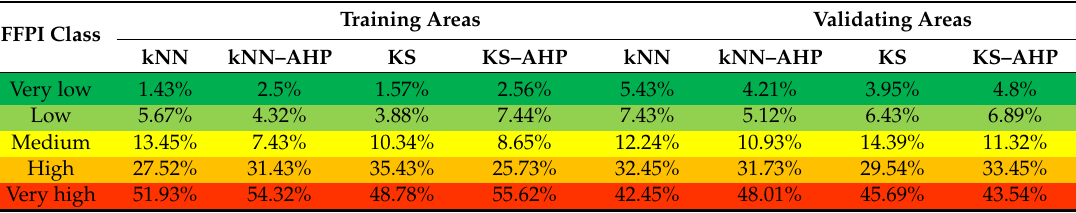
Table 3. Share of torrential pixels in Flash-Flood Potential Index (FFPI) classes.